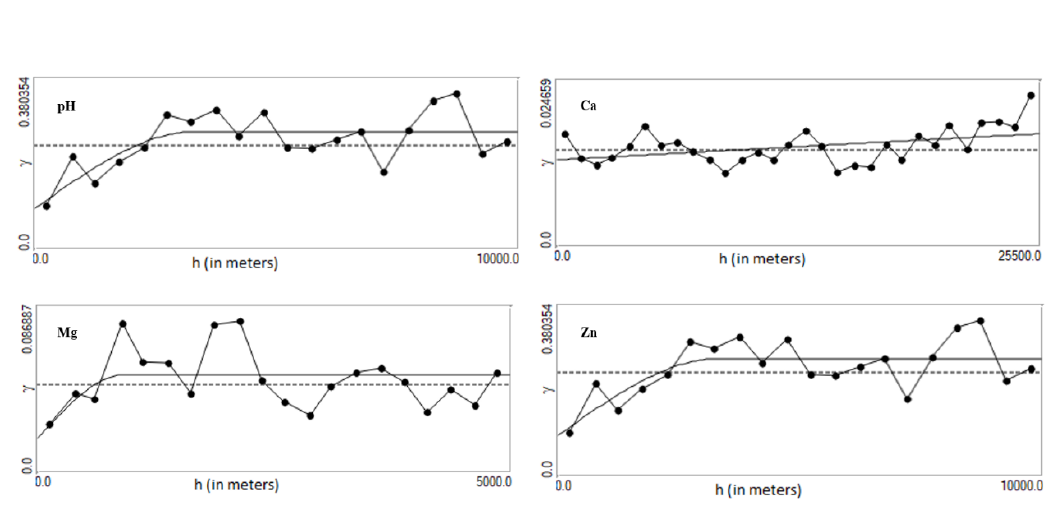
Figure 4. Semivariogram for soil pH, Ca, Mg and Zn